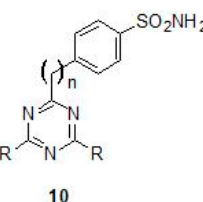
Figure 5. General chemical structure of triazinyl sulfonamides ( 10 ).